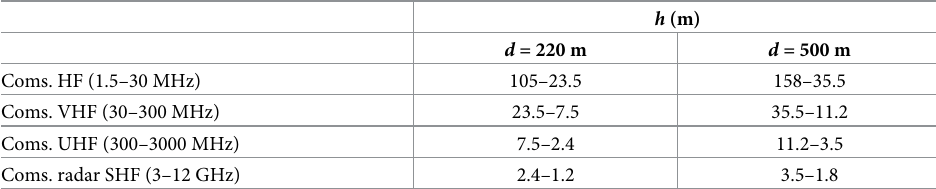
Table 4. First Fresnel’s ellipsoid height for h UAV = h AUT = 21.5 m.